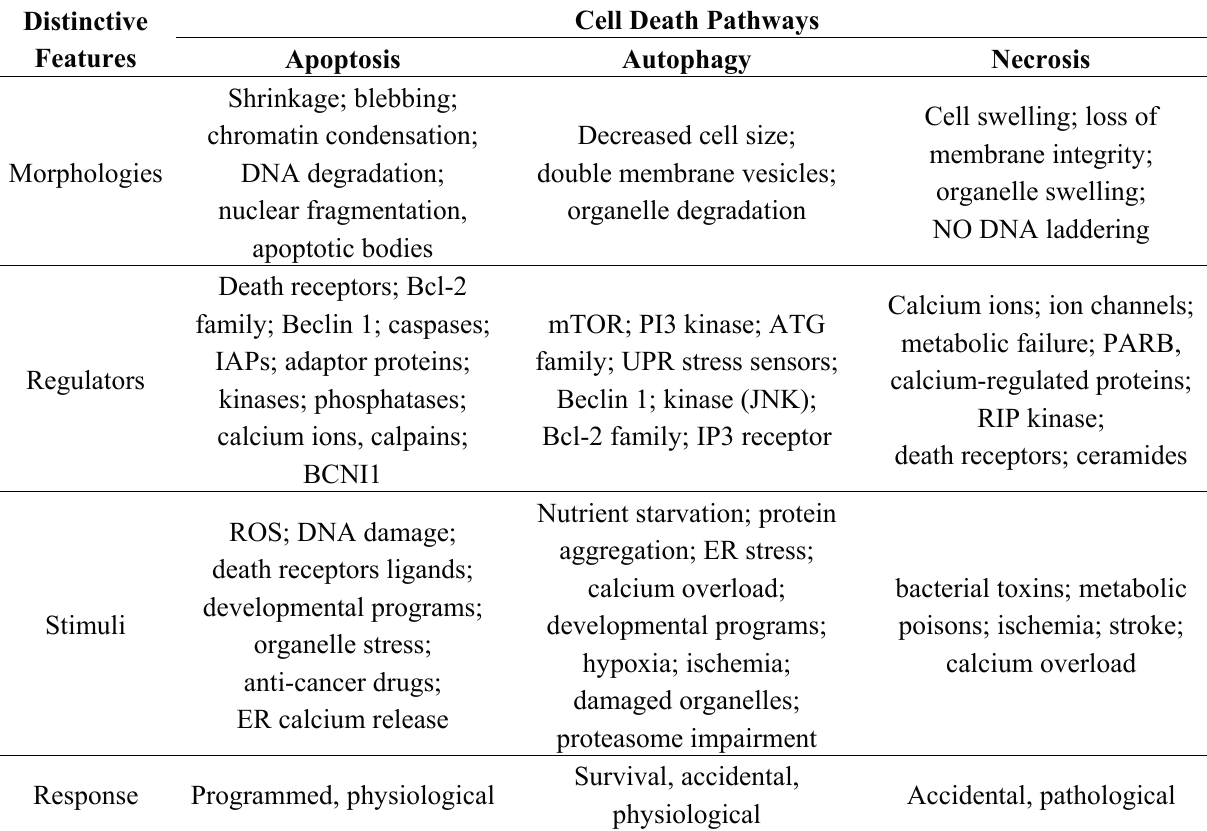
Table 1. Distinctive characteristics of cell death pathways. Different cell death pathways can be classified according to morphological appearance (apoptotic, autophagic, necrotic), enzymological criteria or regulators (distinctive classes of proteases, such as caspases, calpains and kinases) and functional aspects (programmed or accidental, physiological or